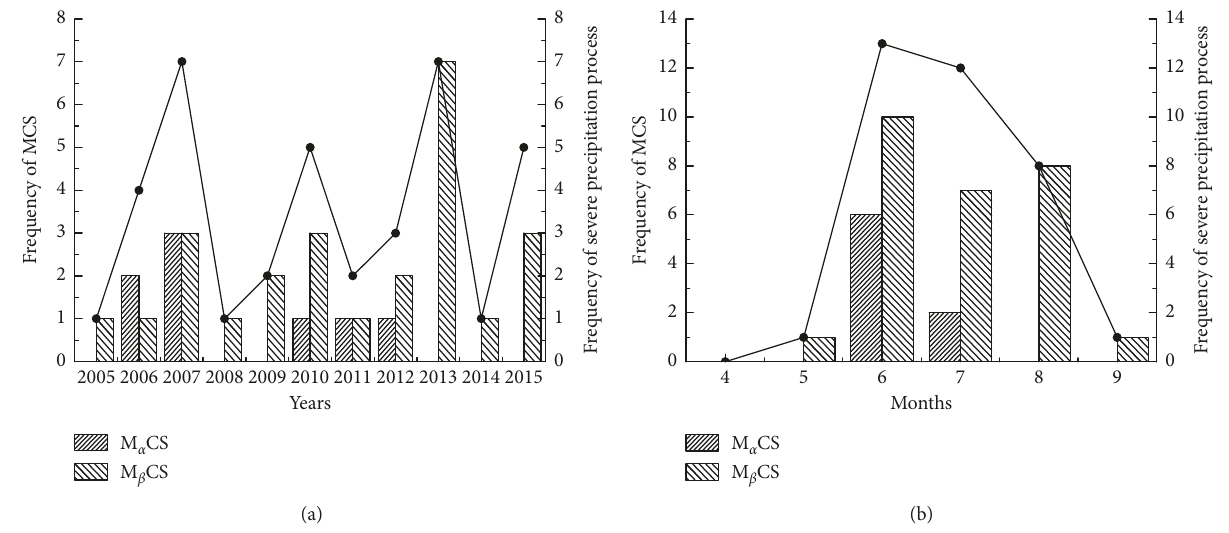
Figure 4: Frequency variations among MCS events of different scales and heavy precipitation processes: (a) annual variations; (b) monthly